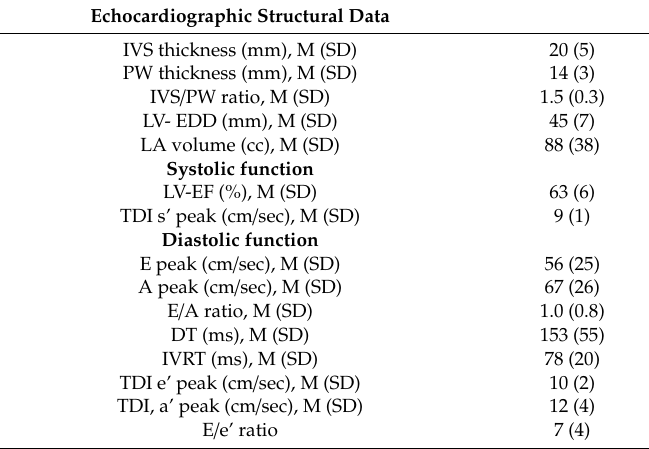
Table 2. Echocardiographic data of HCM